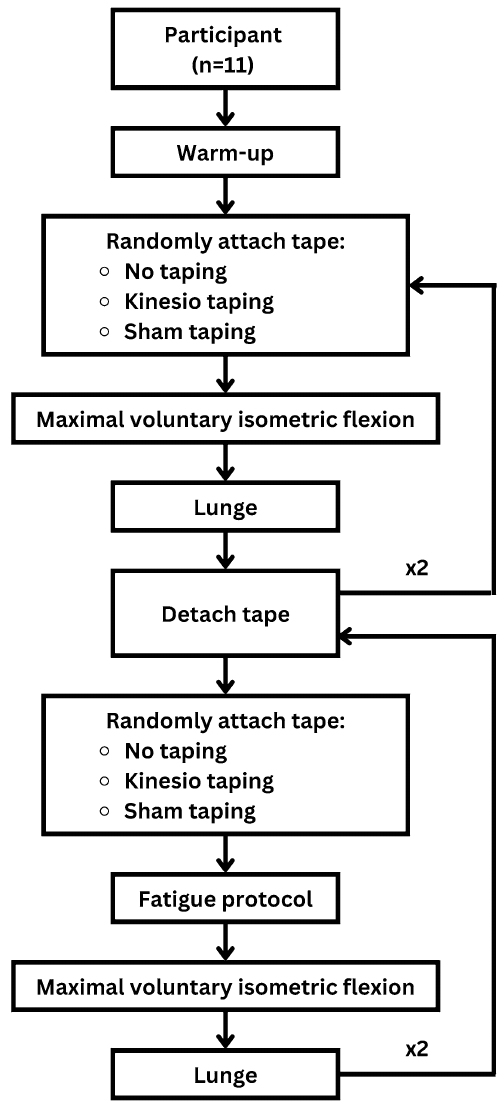
Figure 5. Schematic presentation of experimental